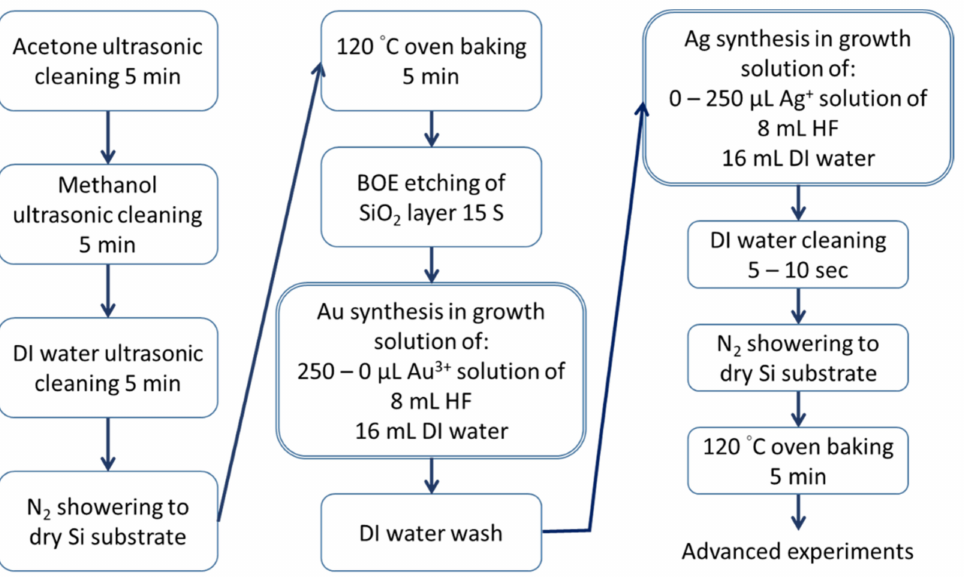
Figure 2. Process of the Galvanic replacement reaction in Au@Ag-DNFs/Si synthesis.